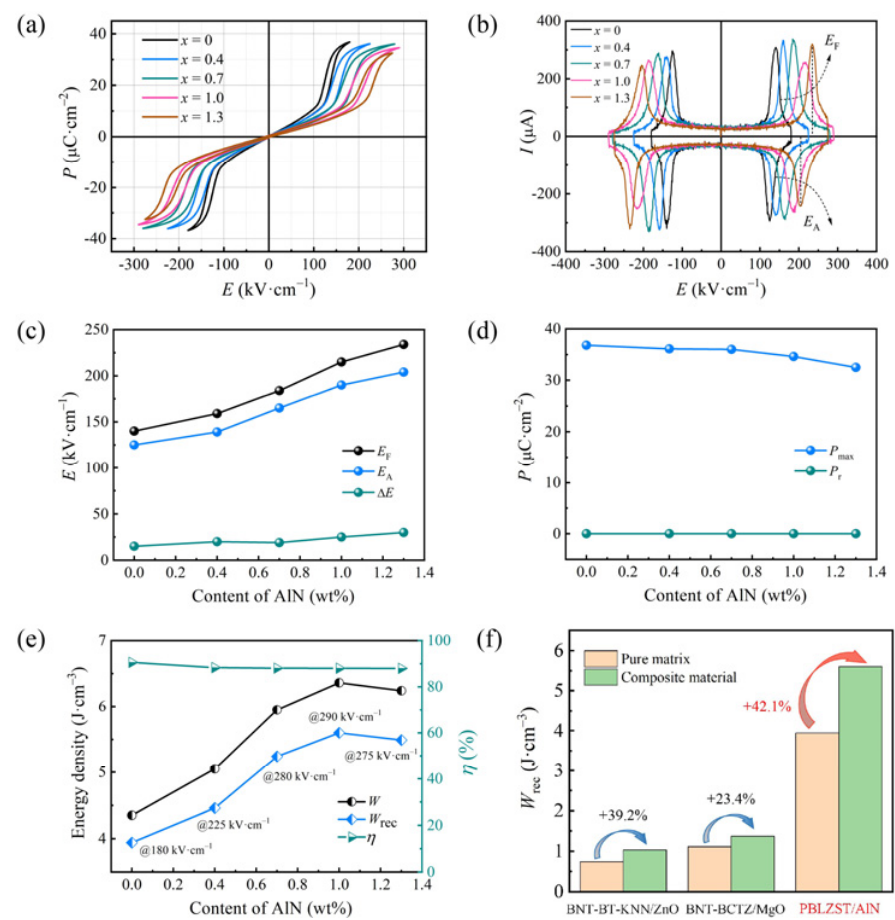
Fig. 6 (a) P – E loops of the PBLZST: x wt% AlN ceramics under each of their corresponding maximum testable electric